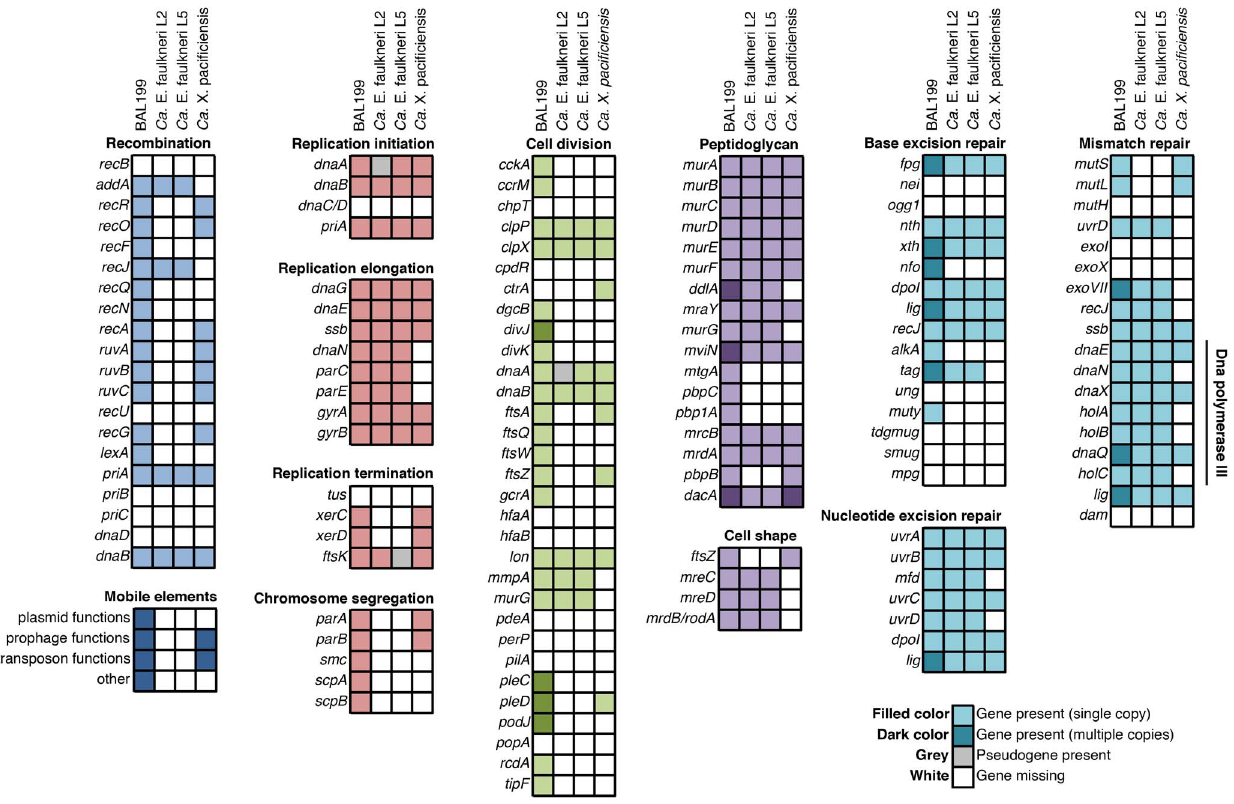
Figure 5. Ca. E. faulkneri is missing key genes involved in the processes of recombination, replication, cell division and mismatch repair. Note: some genes are repeated in multiple categories. The BAL199 and Ca. X. pacificiensis genomes are not closed, and so genes presented as missing above may possibly be present but not assembled.